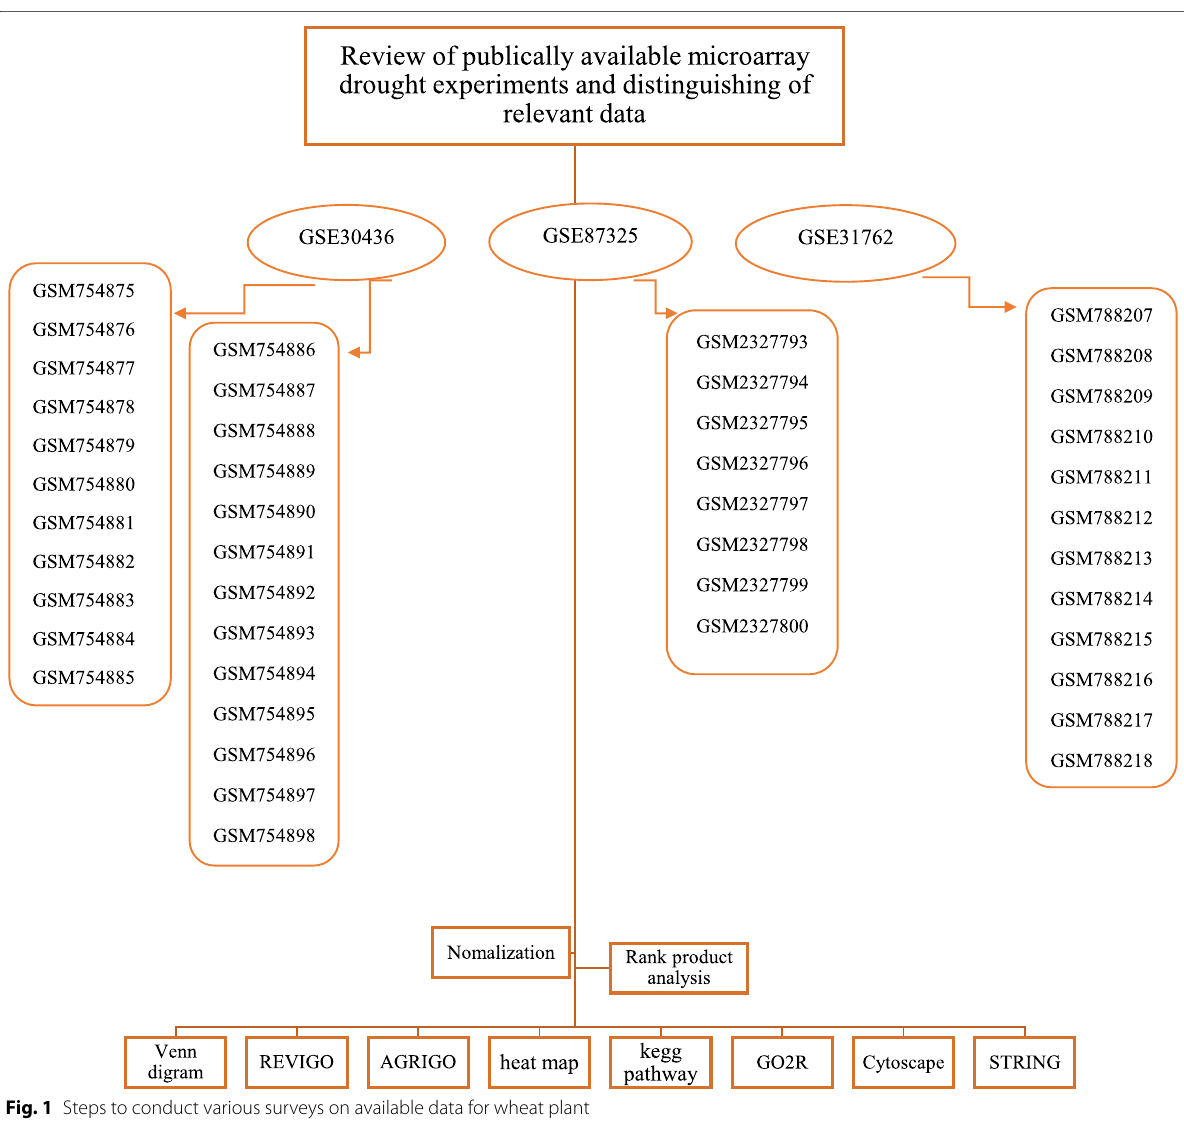
Fig. 1 Steps to conduct various surveys on available data for wheat plant